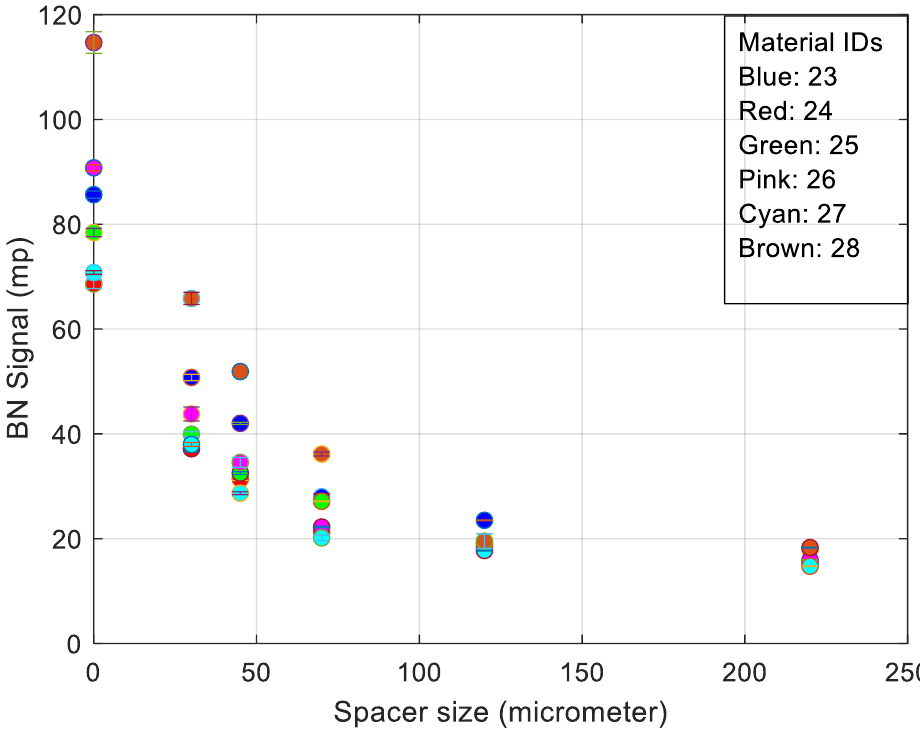
Figure 5. BN signal response for bottom surface in longitudinal orientation.